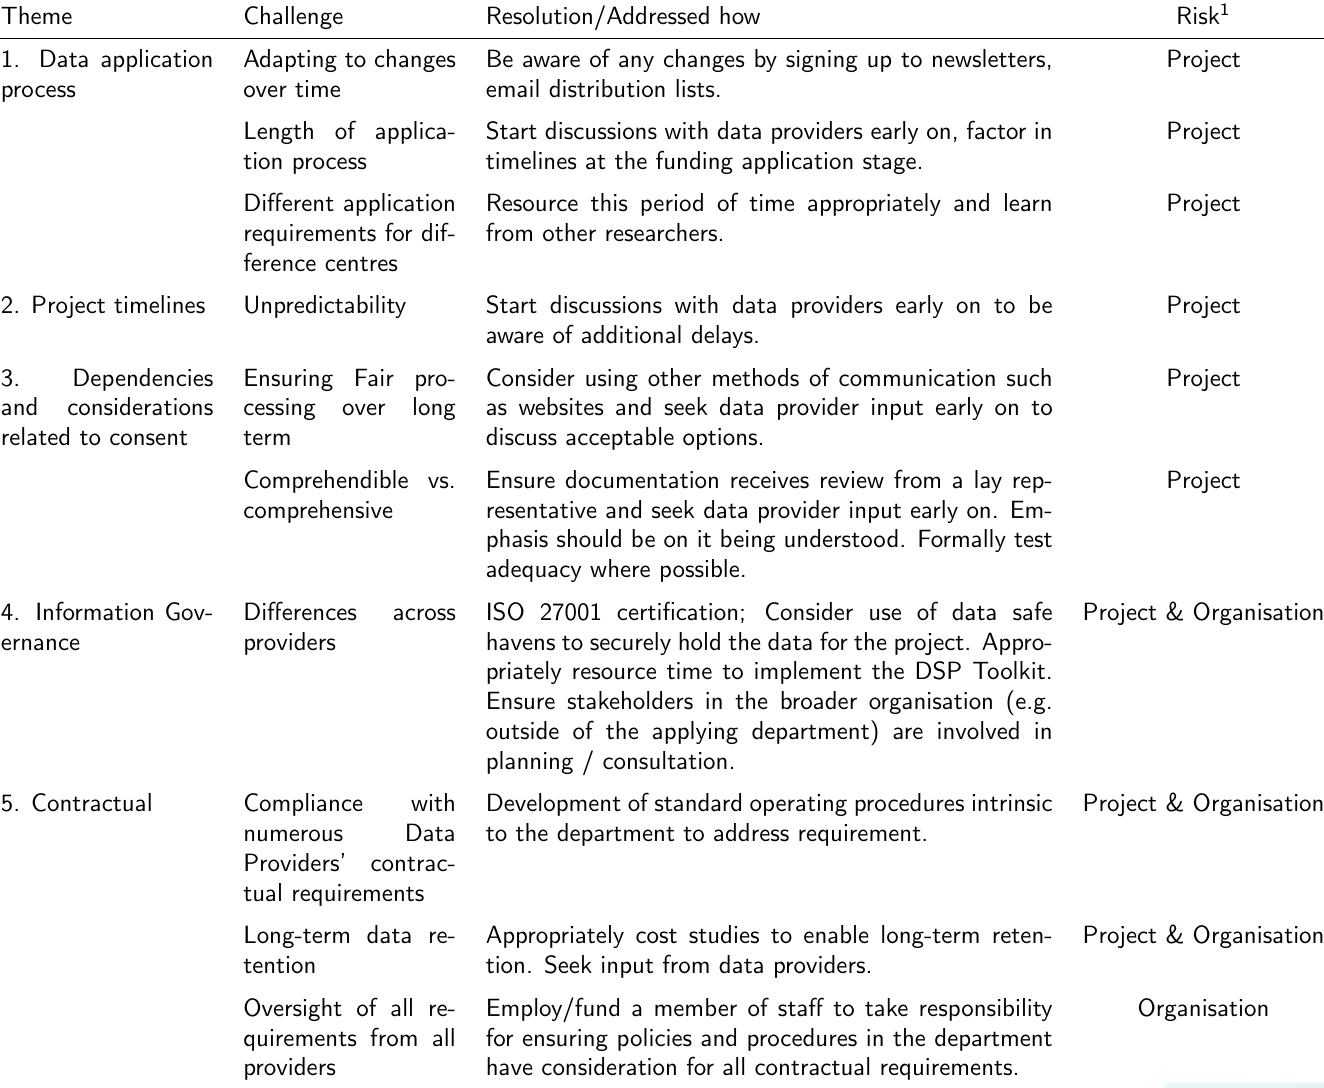
Table 3: Challenges faced by the research team and proposed resolutions